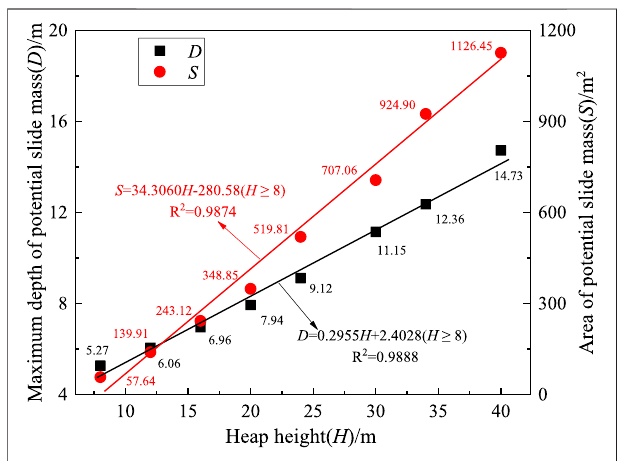
FIGURE 5 | Variations of maximum depth and area of potential slide mass with heap height at G = 1:2.50.